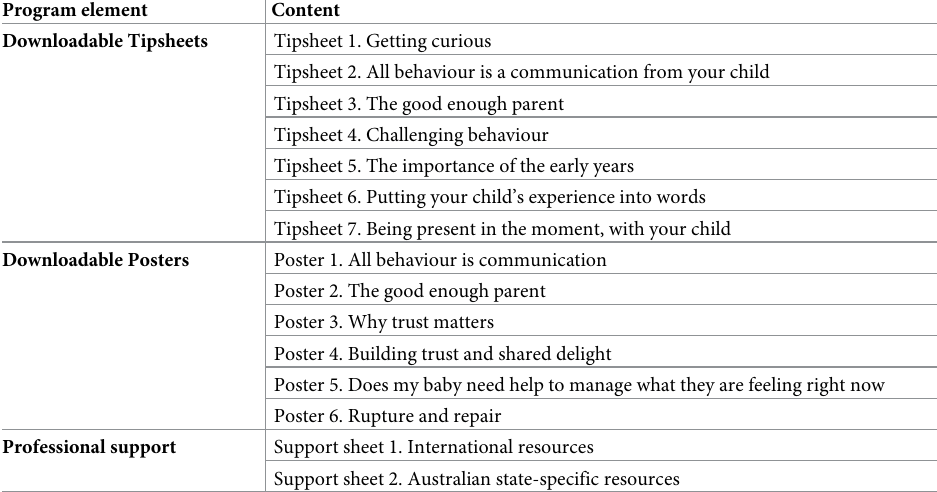
Table 2. Non-video MERTIL for Parents